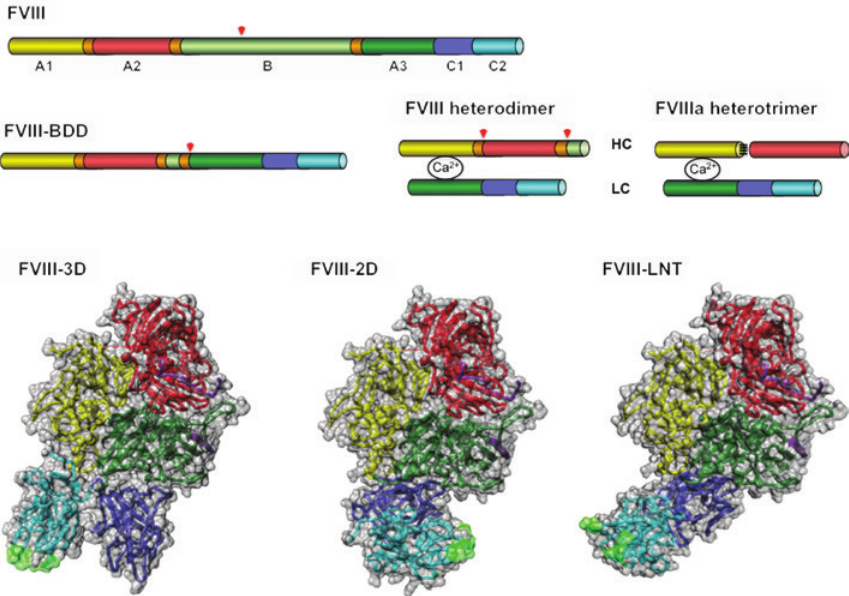
Figure 3: Domain organization of factor VIII. Factor VIII (FVIII) is a six-domain 2332-amino acid residue single-chain protein, consisting of three homologous A domains, two homologous C domains, and a heavily glycosylated B domain. FVIII-BDD is the B domain deleted recombinant FVIII molecule expressed without the B domain, which is replaced with a short linker of ~ 20-amino acid residues (light green). FVIII heterodimer is the form FVIII exists in solution where the heavy (HC) and light (LC) chains are non-covalently linked via divalent metal ions (Ca 2 + ). FVIIIa heterotrimer is the thrombin-activated form of FVIII where the B domain/linker is fully excised by proteolytic cleavage (red arrows) at the acidic sequences (in orange) located between the A and B domains. The A1 and A2 domains of the heavy chain are held solely by hydrophobic interactions. FVIII-3D is the FVIII structure in solution, as organized in 3D crystals 3CDZ.PDB [98]. FVIII-2D is the membrane- bound FVIII structure from electron crystallography of FVIII organized in 2D crystals bound to a lipid monolayer surface 3J2Q.PDB [37]. FVIII- LNT is the membrane-bound FVIII structure from CryoEM of helically assembled FVIII molecules bound to LNT 3J2S.PDB [11, 36]. The five FVIII domains are color coded as in the primary sequence. The residues identified at the C2 domain-membrane interface are shown with a green surface. The sequences identified at the A2 and A3 domain-FIXa interface are indicated with purple ribbons. The three FVIII structures are shown with the FVIII heterotrimer in the same